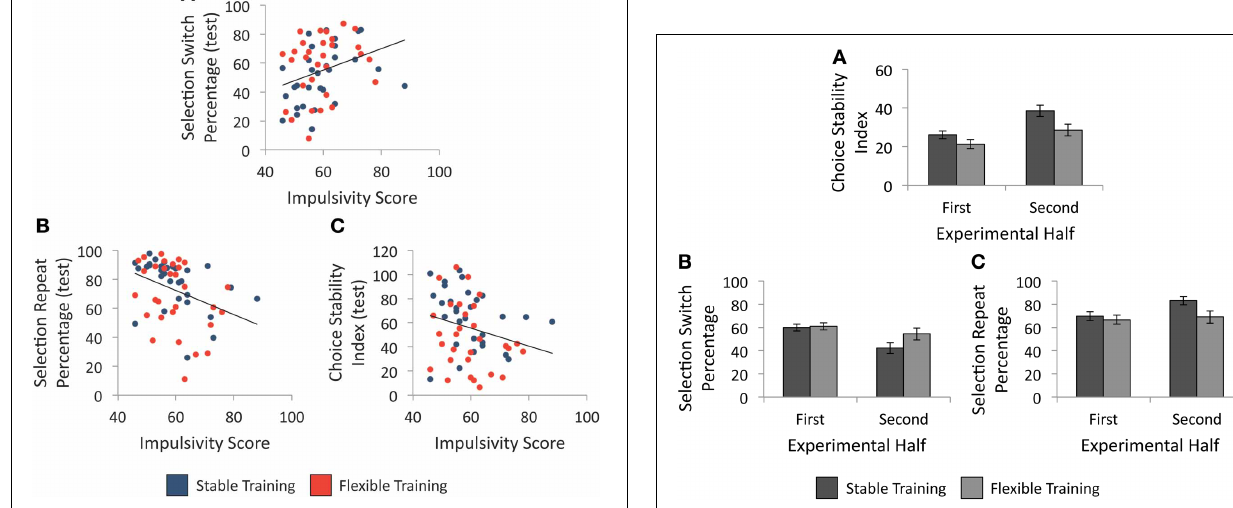
FIGURE 5 | Behavioral results from the test phase. (A) Choice stability index as a function of training group. Participants continued to make less variable responses following the stable training than following the flexible training. (B) Percentage of trials following an unrewarded selection in which participants selected a different object than their previous selection, as a function of training group. (C) Percentage of trials following a rewarded selection in which participants made the same selection as they had on the previous trial, as a function of training group. Error bars denote 1SE above and below the